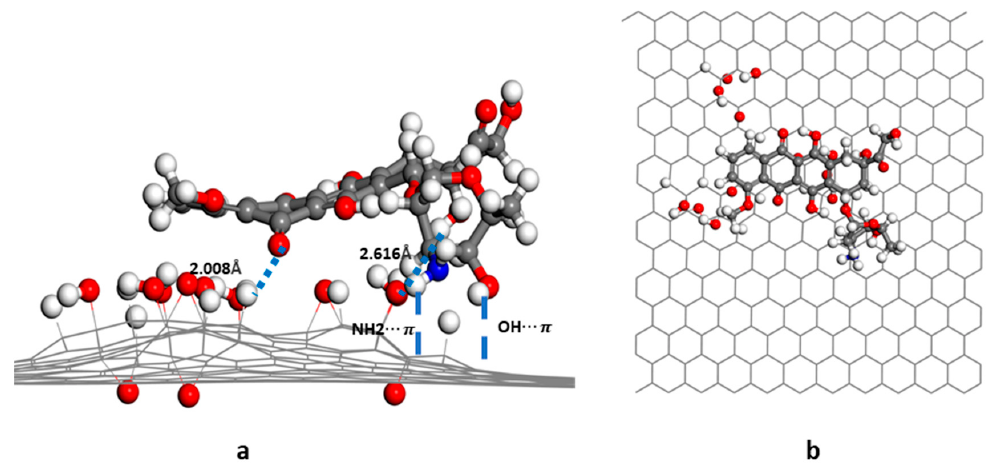
Figure 7. Energy-minimized structure of GO-OH-O-DOX; ( a ) side view; ( b ) top view. Table 2. Hydrogen bond length of DOX and graphene system molecules (Å). The annotation of O1 to O4 have shown in Figure 1 .